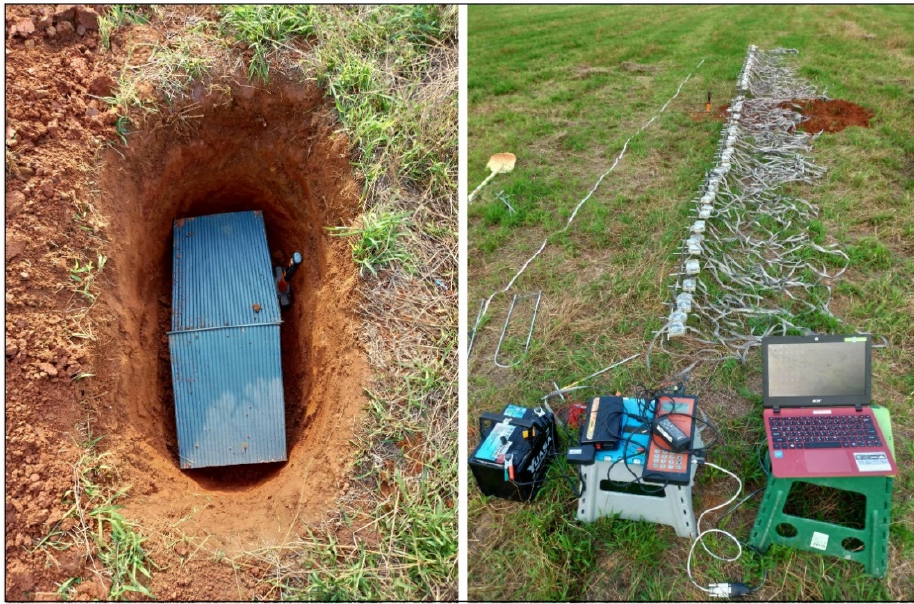
Figure 21. The experimental data collection procedure for resistivity imaging.